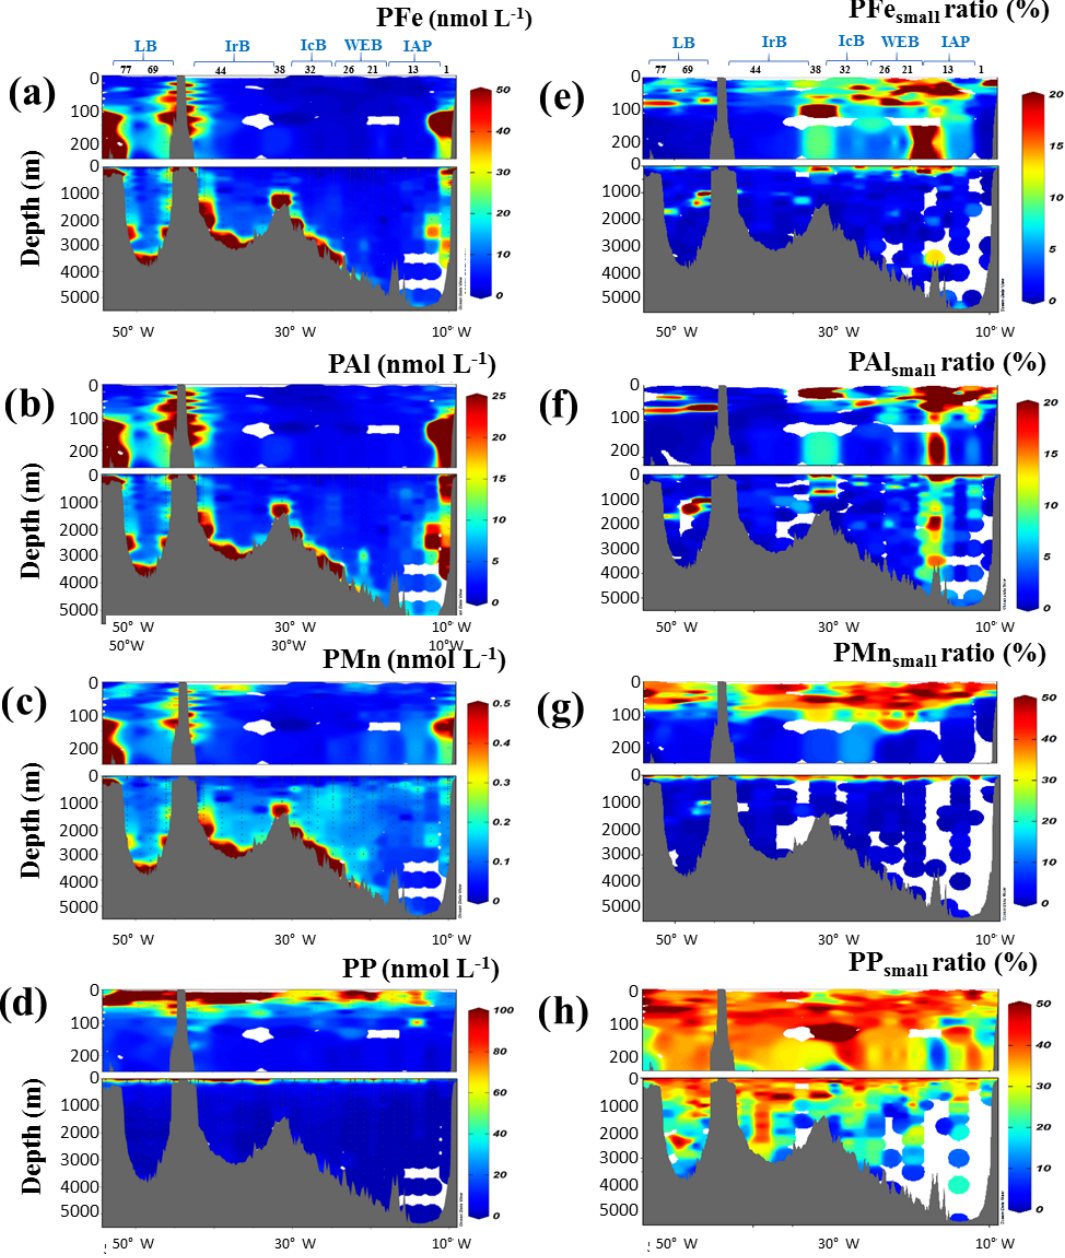
Figure 3. (a–d) Distribution of total particulate (a) iron (PFe), (b) aluminium (PAl), (c) manganese (PMn), and (d) phosphorus (PP) con- centrations (nmolL − 1 ) in the first 250m and the entire water column along the GEOVIDE section in the North Atlantic Ocean. Right panel: contribution of the small size fraction (0.45–5µm) expressed as a percentage (%) of the total concentration of (e) PFe, (f) PAl, (g) PMn, and (h) PP. Station IDs and biogeochemical regions are indicated on top of panels (a) and (e) . This figure was generated using Ocean Data View (Schlitzer, R., Ocean Data View, http://odv.awi.de/,